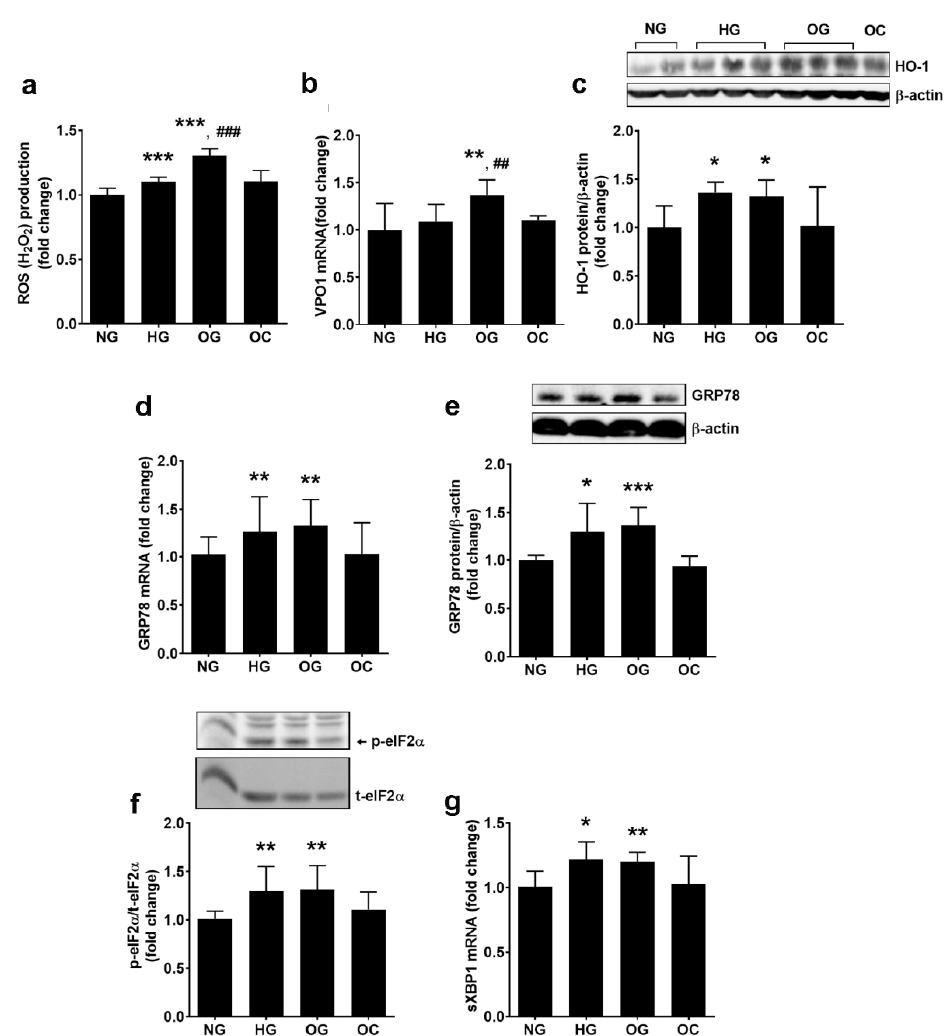
Figure 5. Oscillating glucose generates oxidative stress and endoplasmic reticulum stress in EC. Cells were exposed to 5 mM glucose (NG), 25 mM glucose (HG) or alternatively to 5 mM/25 mM glucose (OG) at every 3 h, for 72 h. Cells exposed alternatively to L -glucose or mannitol (using the same protocol as for OG) were considered osmotic control (OC). ( a ) Intracellular reactive oxygen species (ROS) levels; ( b , d , g ) mRNA levels of VPO1 ( b ), GRP78 ( d ) and spliced XBP1 (sXBP1) ( g ); ( c , e ) protein expression of HO-1 ( c ) GRP78 ( e ); ( f ) phosphorylated eIF2 α relative to total eIF2 α ( p -eIF2 α /t-eIF2 α ) (representative blot and densitometric analysis). All data are expressed as fold change versus NG and presented as mean ± SD. * p < 0.05, ** p < 0.01, *** p < 0.001 vs. NG; ## p < 0.01, ### p < 0.001 vs. HG. 3.5. Oscillating Glucose Activates the Pro-Inflammatory NF-kB Transcription Factor and p38 MAPK Oxidative stress and ERS are strong inducers of the pro-inflammatory signaling path- ways initiated by NF-kB and p38 MAPK. Thus, the translocation of NF-kB into the nucleus and the phosphorylation of p38 MAPK were evaluated in ECs from EA.hy926 line in our experimental conditions. The results indicated that OG determined a higher translocation of NF-kB into the nucleus compared to NG or HG (1.41 ± 0.28 for OG, 1.11 ± 0.14 for HG and 1.00 ± 0.08 for NG; p < 0.05 for both OG vs. NG and OG vs. HG; p < 0.01 for all studied groups by ANOVA), as shown in Figure